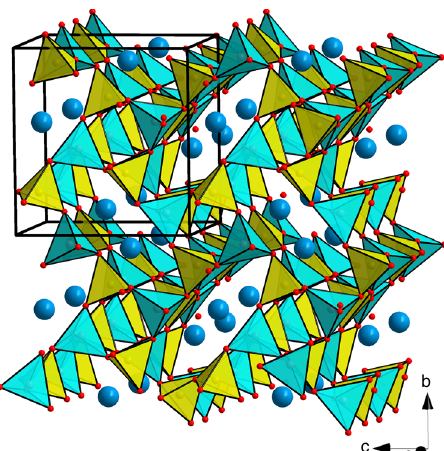
Fig. 1 Crystal structure of hurlbutite, CaBe 2 P 2 O 8 , at ambient conditions 25 . BeO 4 and PO 4 tetrahedra are given in blue and yellow, respectively. Ca and O atoms are given as blue and red spheres, respectively. Black solid line outlines a unit